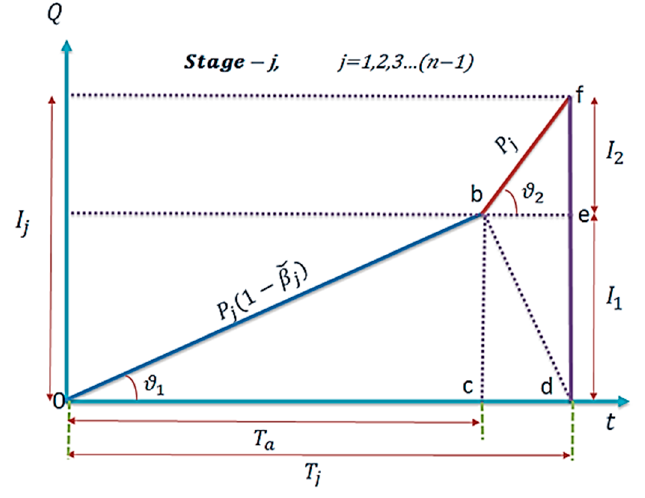
Figure 2. Inventory behavior of stage- j (reference: Tayyab and Sarkar [12]).